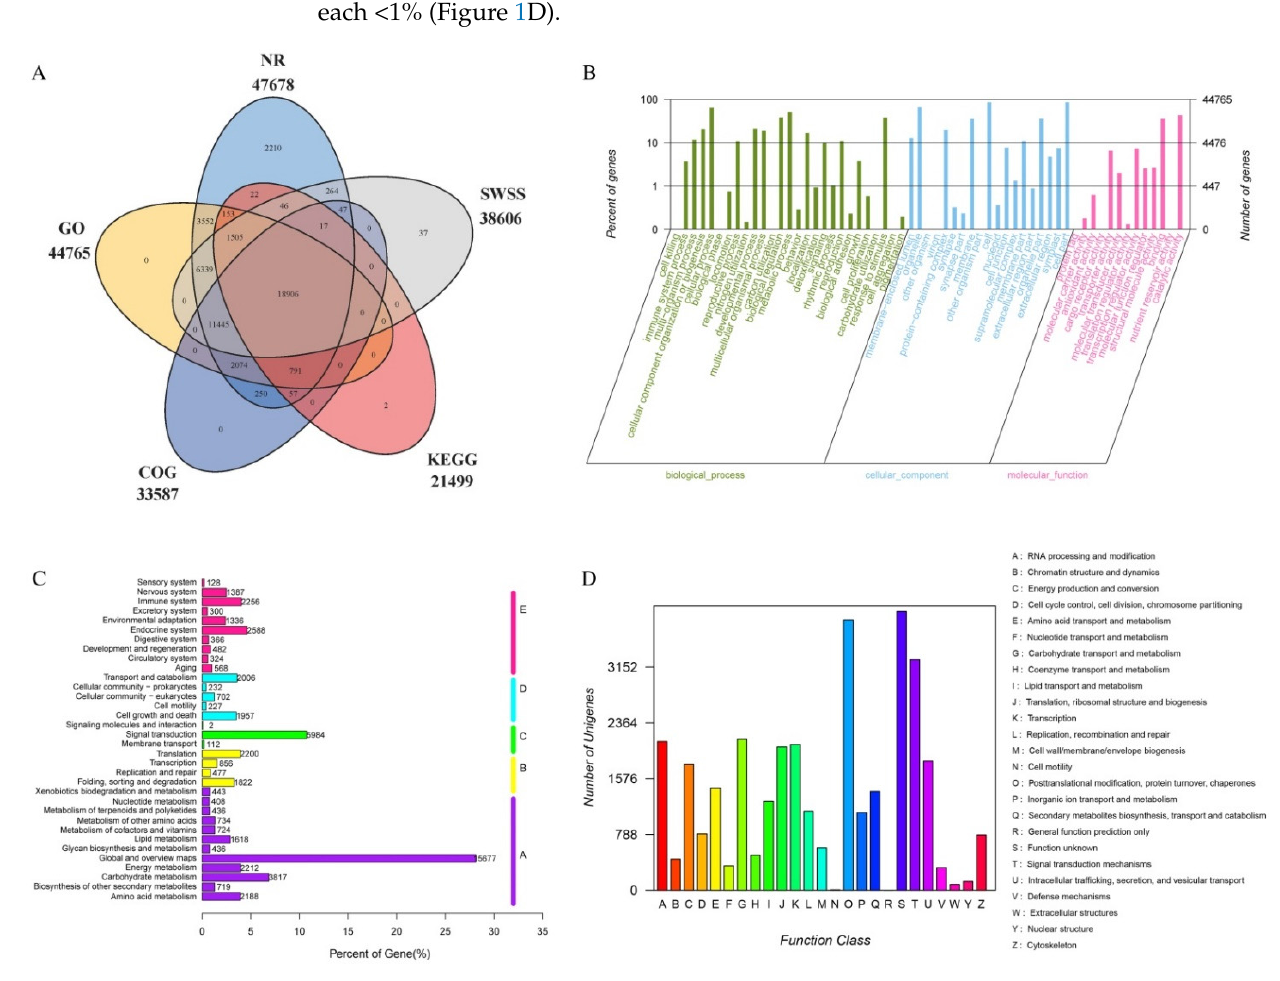
Figure 1. Gene annotation and classification for Chosenia arbutifolia . ( A ) Venn diagrams of reconstructed genes annotated in different databases. ( B ) Gene ontology term classifications for the reconstructed genes. ( C ) General pathway assignment based on KEGG database. ( D ) Histograms depicting clusters of orthologous groups. Table 3. Functional annotation of reconstructed genes.